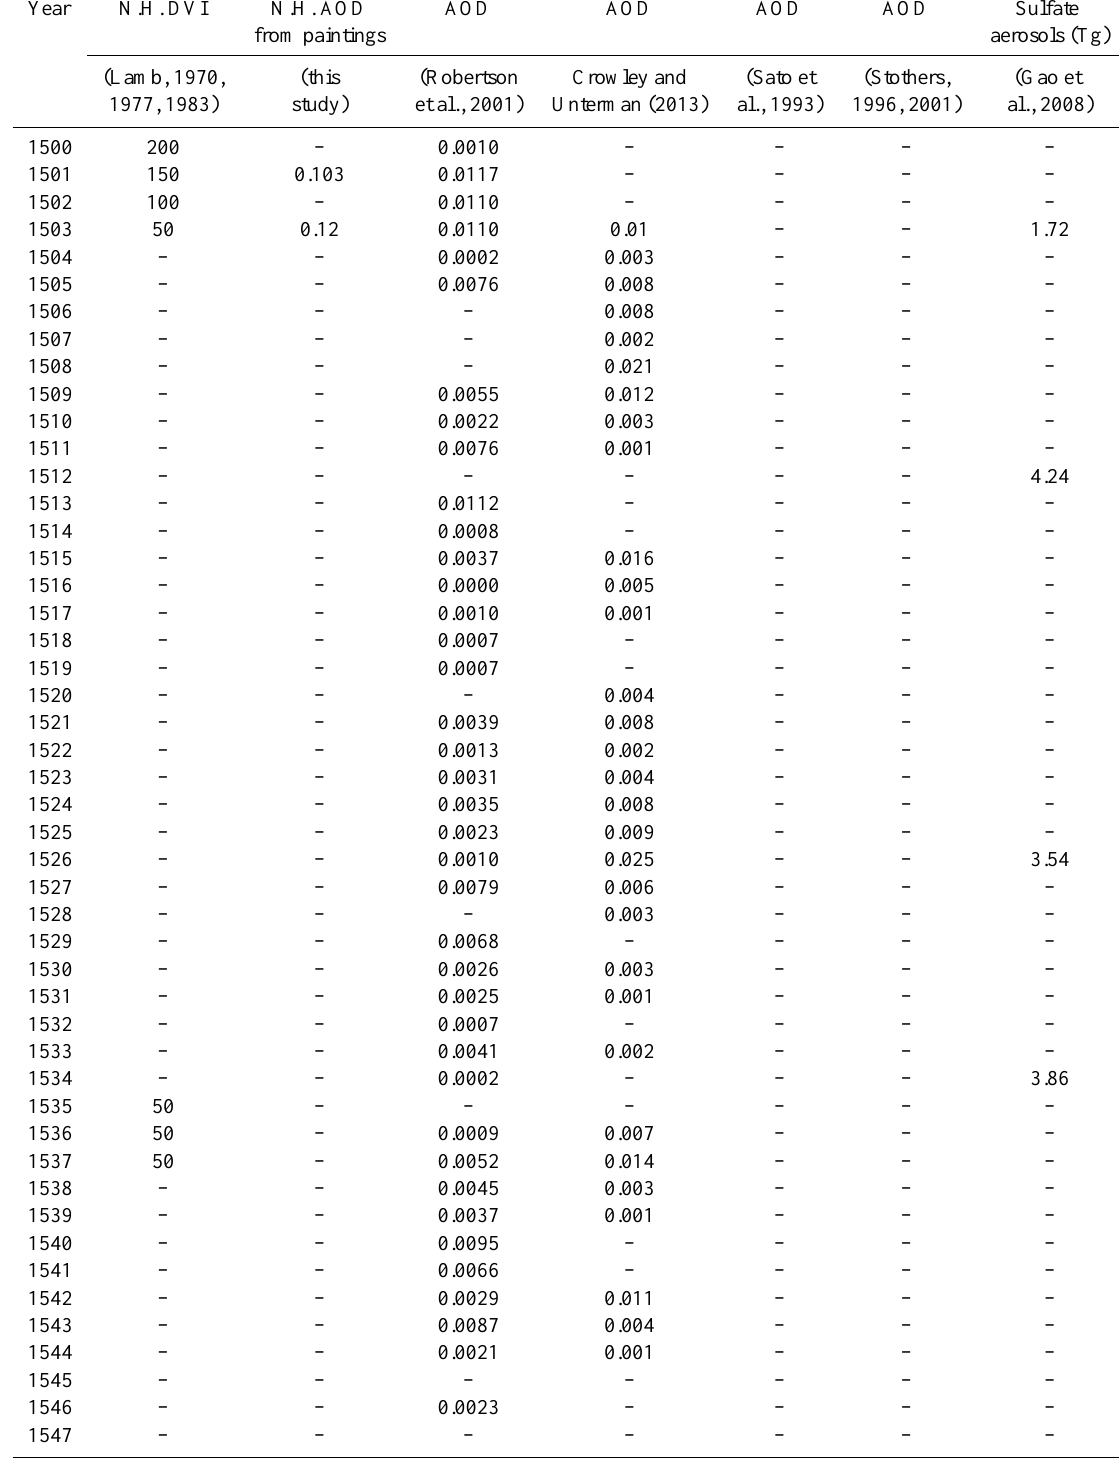
Table D1. Volcanic aerosol indices and AOD proxies shown in Fig.